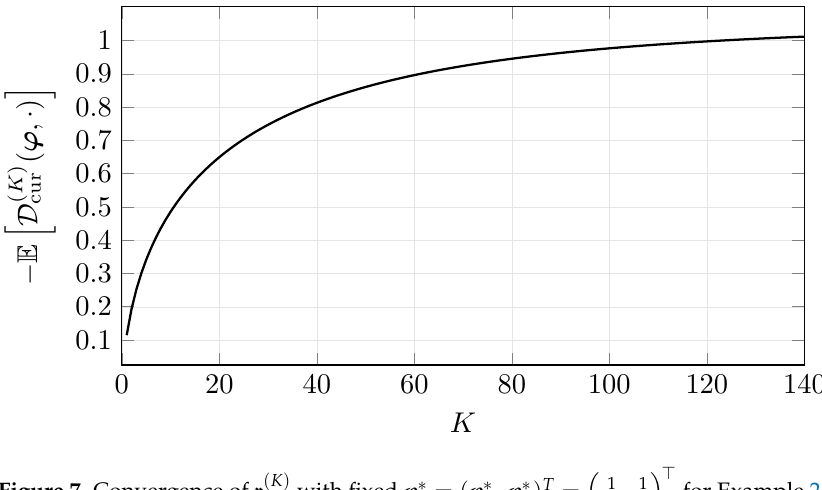
Figure 7. Convergence of r ( K ) cur with fixed ϕ ∗ = ( ϕ ∗